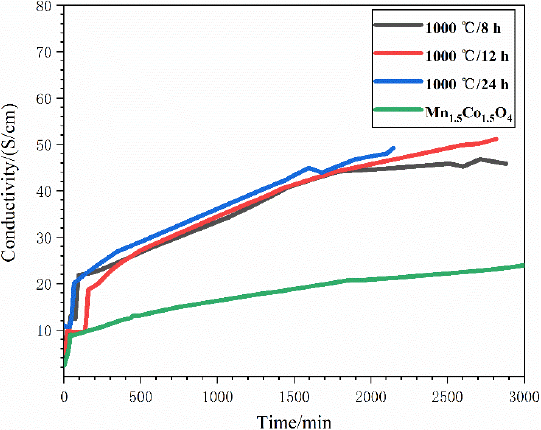
Figure 11. Coatings conductivity prepared from commercial spinel powder and Cu 0.3 Mn 1.5 − x Co 1.5 − y O 4.